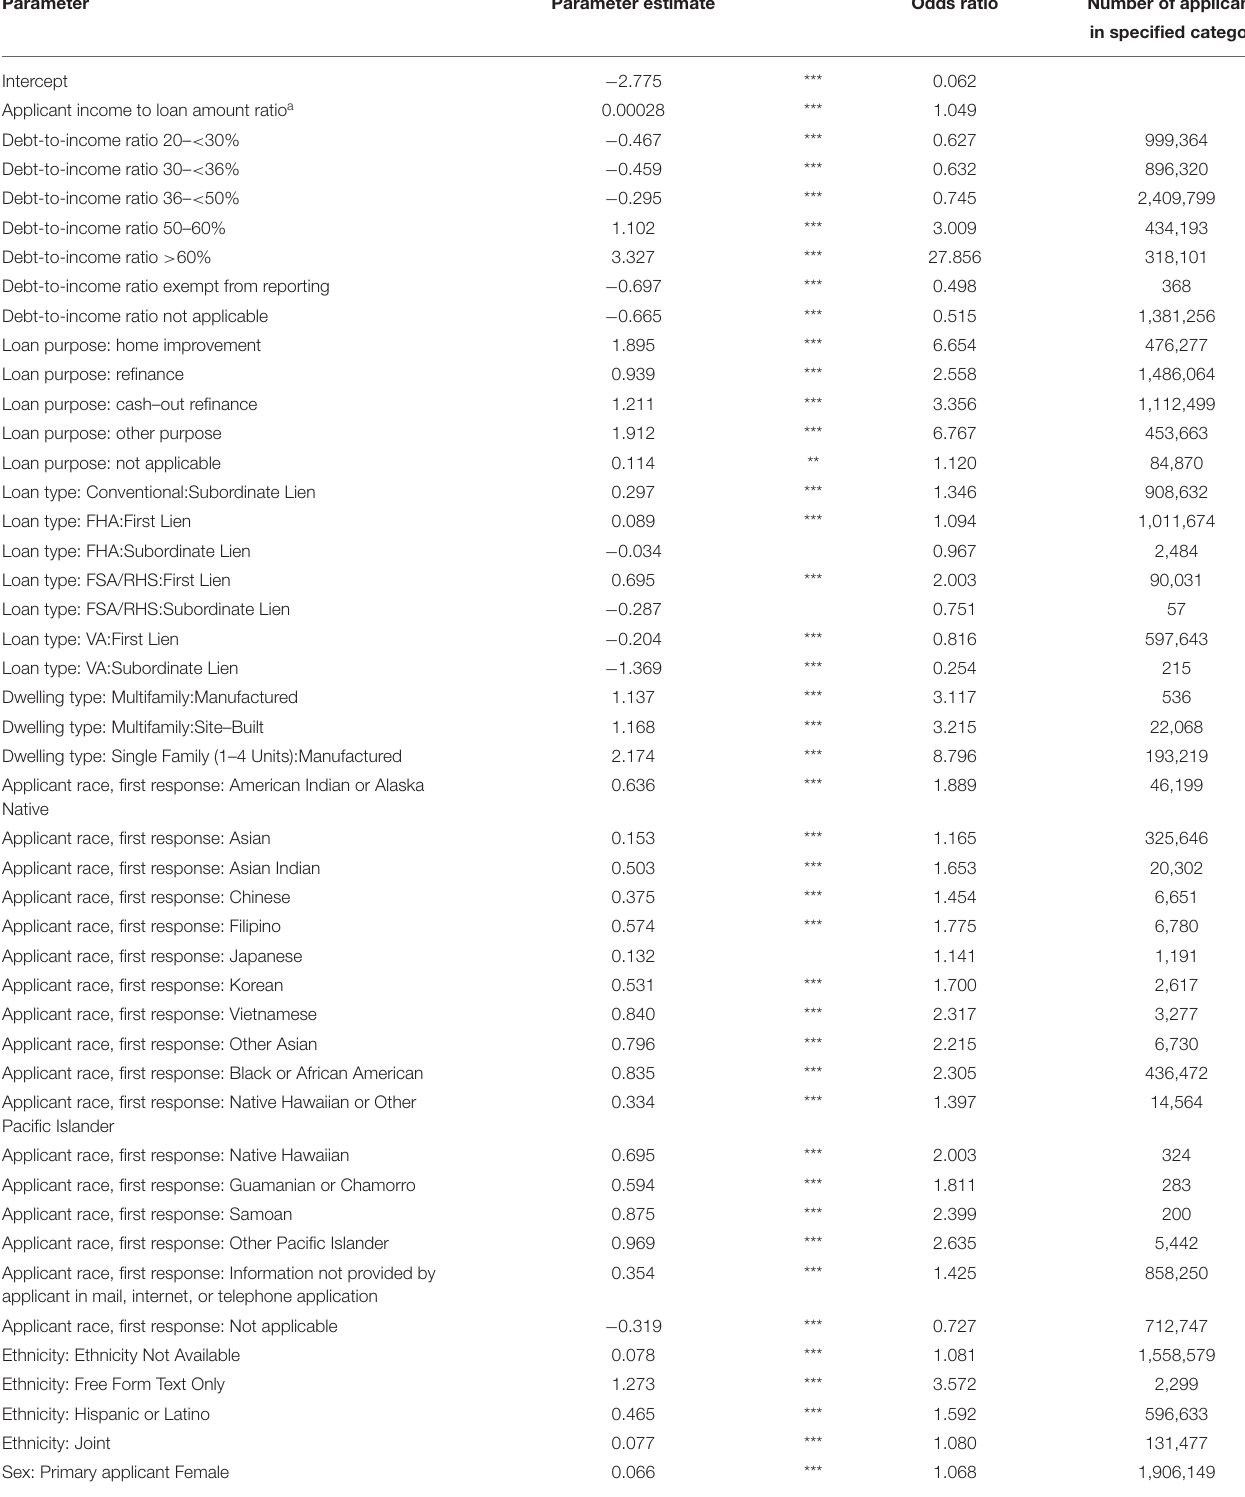
TABLE 3 | Racial stratification of U.S. home mortgage credit, 2019. Parameter Parameter estimate Odds ratio Number of applicants